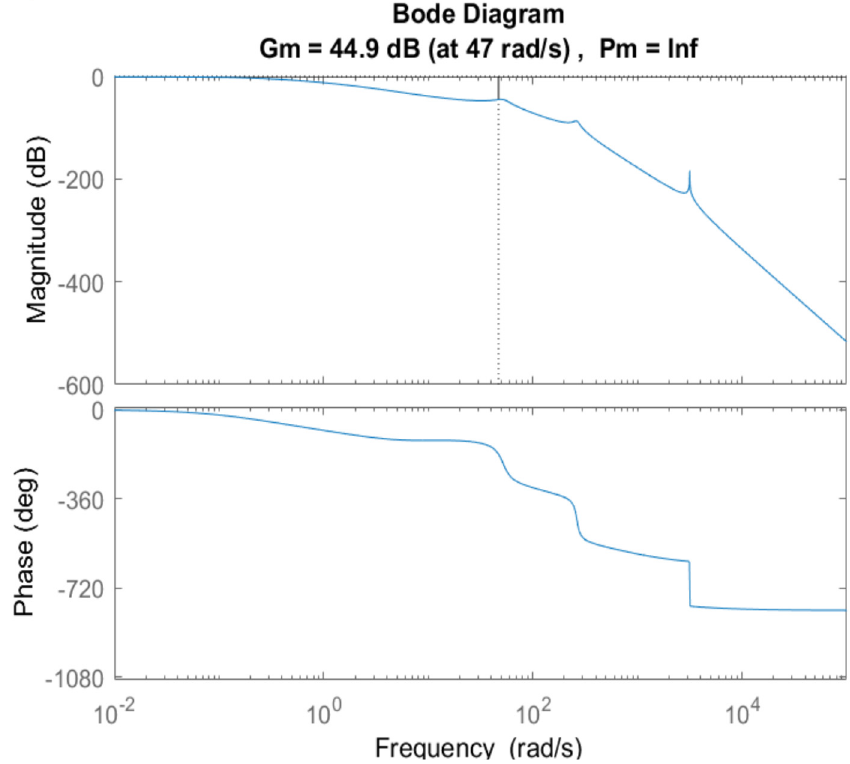
Figure 7. Stability analysis of the proposed model.